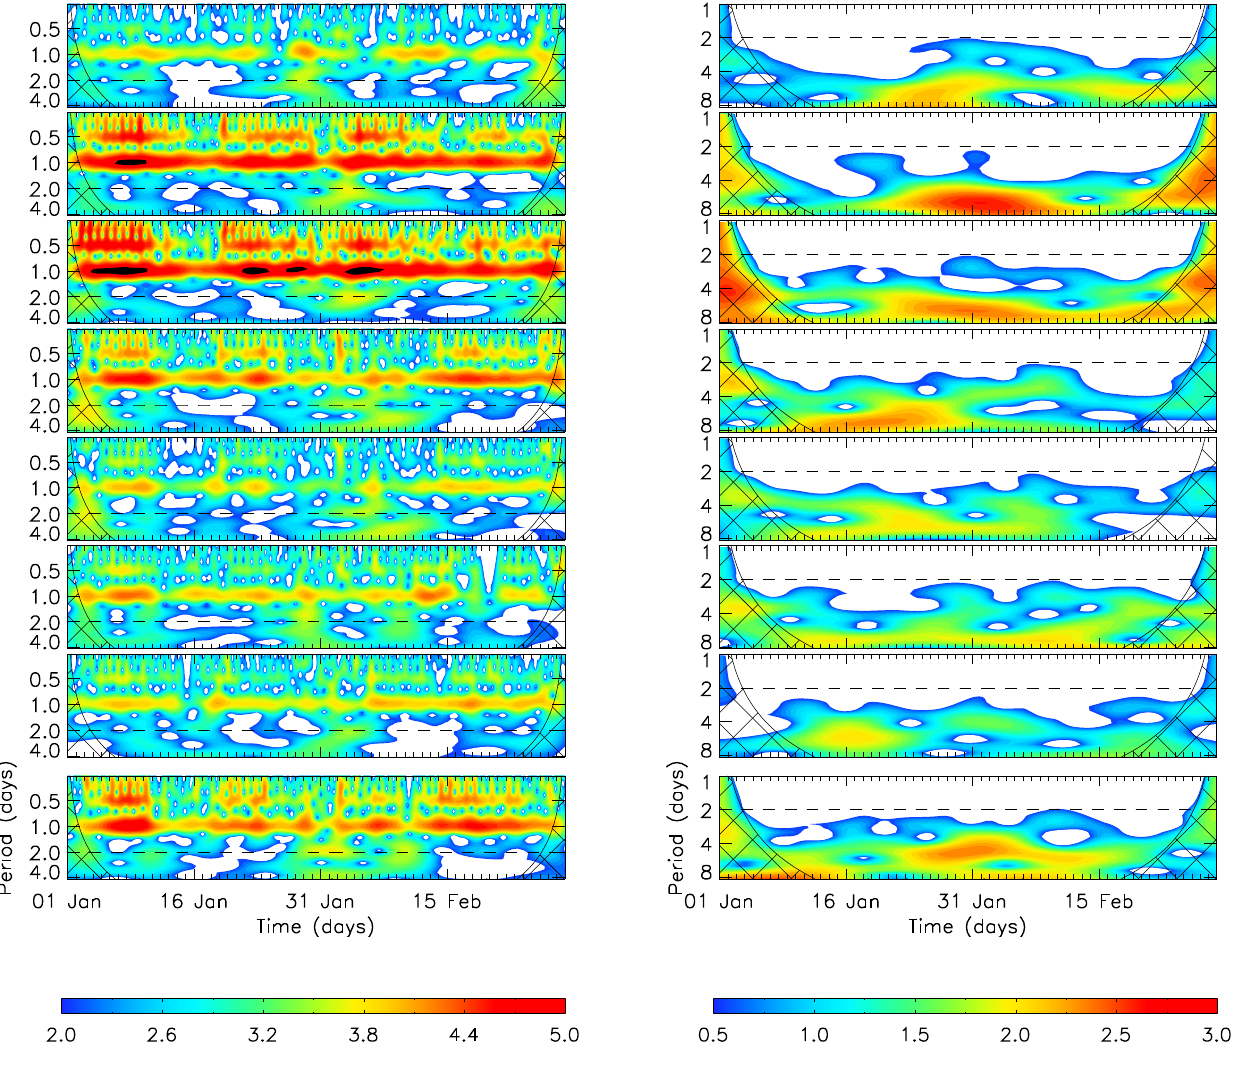
Fig. 2. Space-scale energy density in log-scale of dH in January– February 2003 for the eight magnetic stations (from top to bottom): ASC, SLZ, HUA, TIR, PND, BNG, GUA, and AAE.